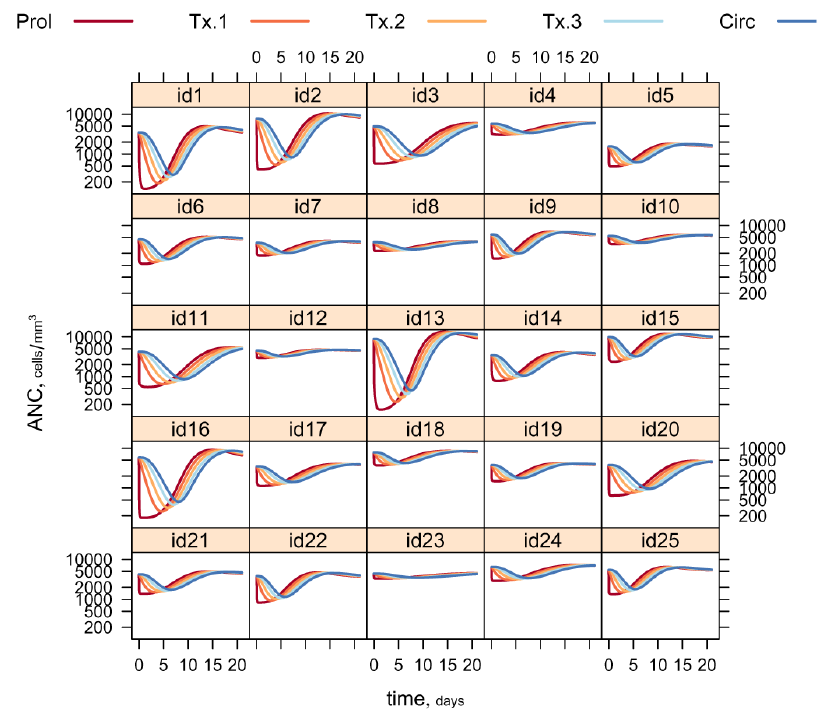
Figure 3. Myelosuppression profiles for the same 25 randomly generated individuals as in Figure 1. Note how a chemotherapeutic ‘shock’ to the proliferative compartment Prol propagates through the maturation compartments Tx Circ . ( ANC : absolute neutrophil